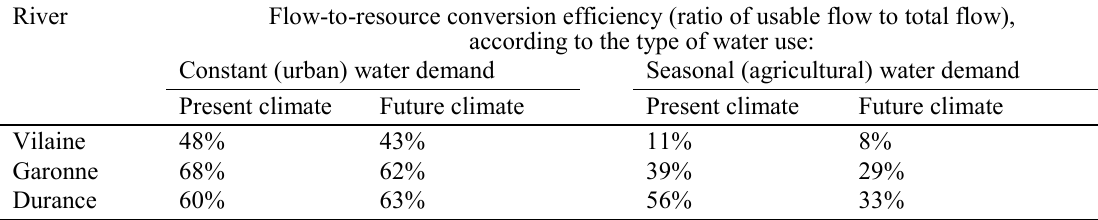
Table 5 Resource conversion efficiency simulated for the three French rivers under two water demand hypotheses. Other hypotheses: no reservoir storage, in-stream reserved flow equal to 10% of the module.